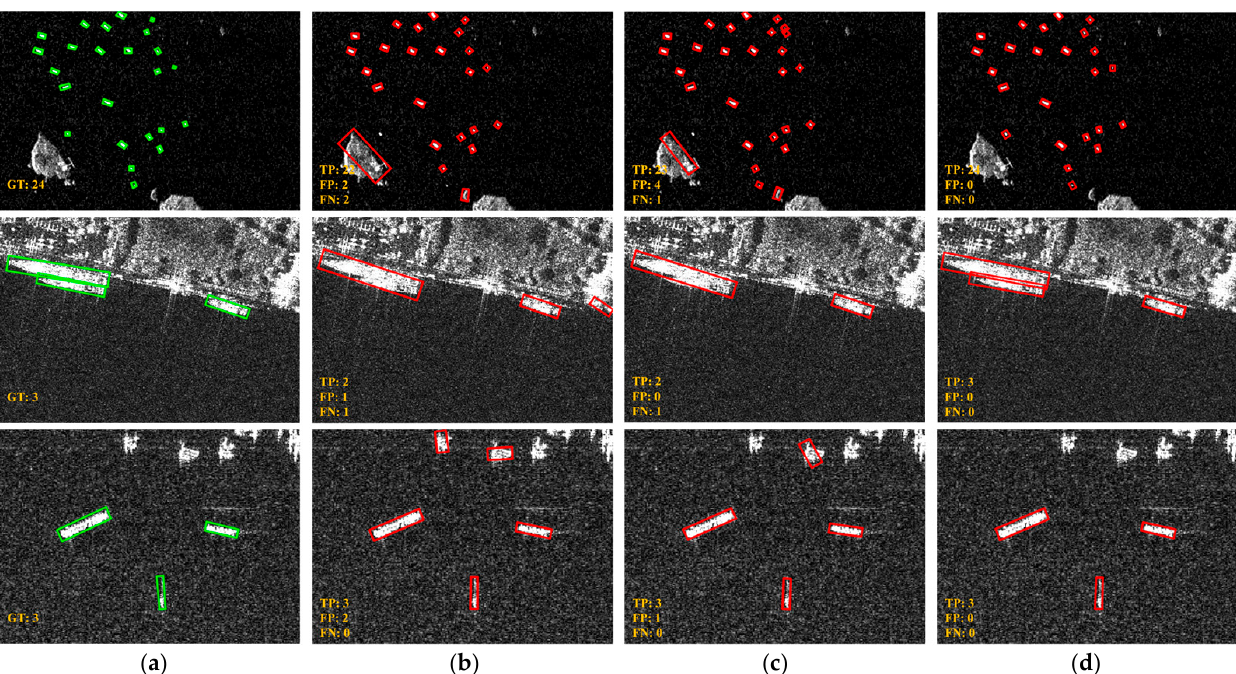
Figure 25. Detection results of different methods on SSDD. ( a ) GT; ( b ) CS 2 A-Net; ( c ) GWD; ( d ) TDIoU + AW-FPN (ours).